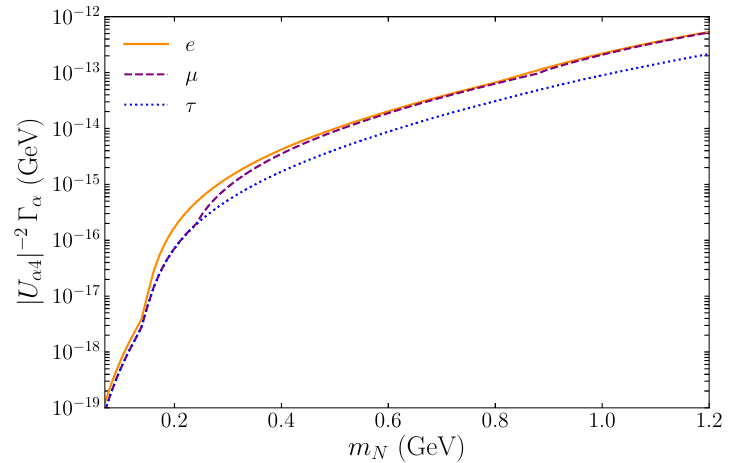
Figure 5 . Ratios j U (cid:11) j (cid:0) 2 (cid:0) (cid:11) for (cid:11) = e; (cid:22); (cid:28) as a function of m N .